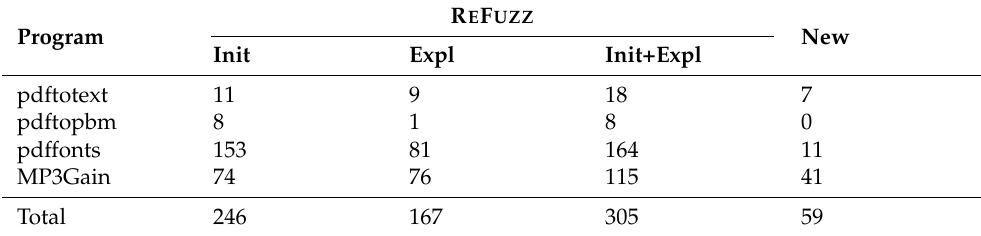
Table 4. Number of unique crashes (50 + 30).